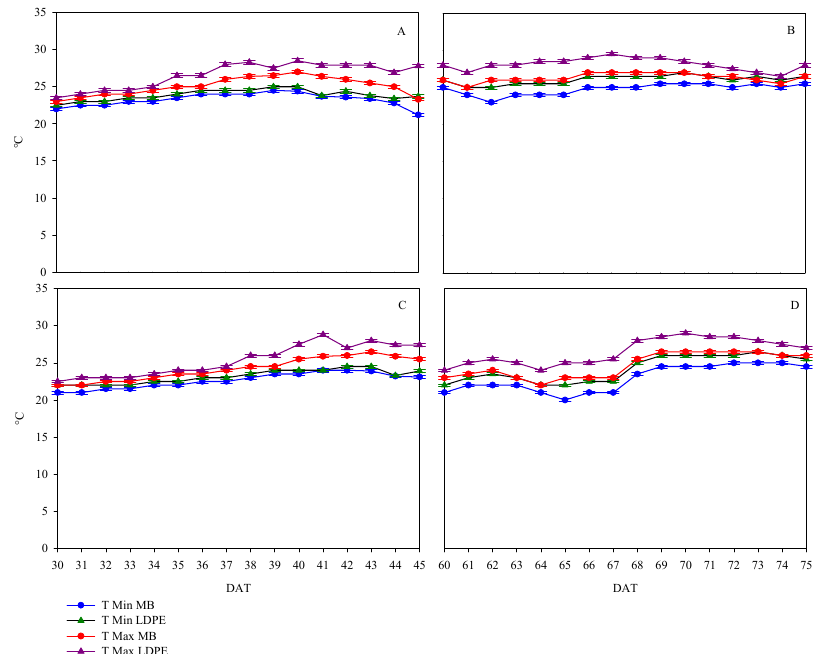
Figure 1. Average daily trends of maximum and minimum temperatures under the two mulching films (biodegradable film—MB; low density polyethylene—LDPE) in sandy loam soil (SL—Pellegrino farm) and clay–loam soil (CL—Ferrara farm) during two periods of muskmelon cycle ( A = 30–45 DAT, B = 60–75 DAT for SL; C = 30–45 DAT, D = 60–75 DAT for CL). Vertical bars show the standard error.